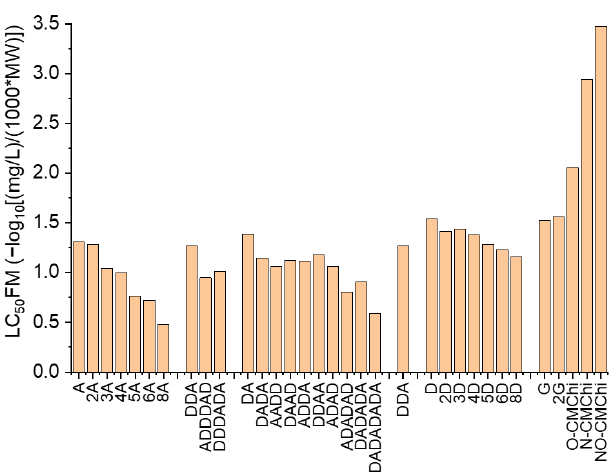
Figure 5. The 96 h fathead minnow LC 50 predicted values for chitooligosaccharides and their